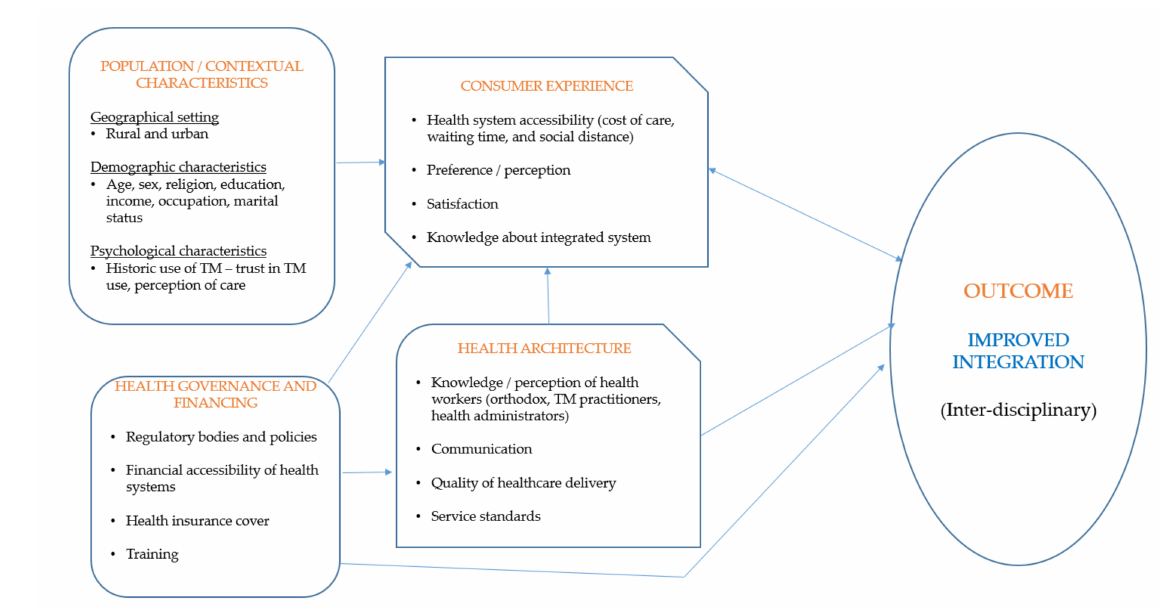
Figure 1. Conceptual framework for integrating TM into health systems. Source: Adapted from Park and Canaway